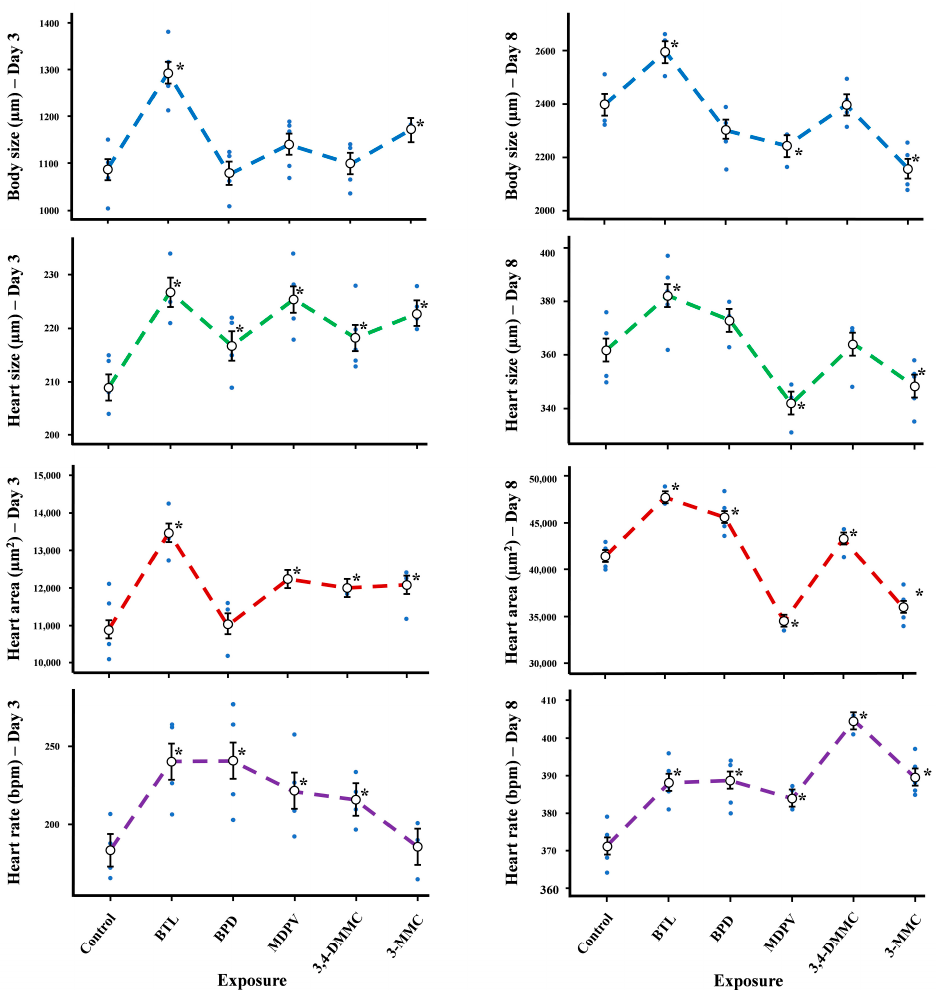
Figure 3. Morphophysiological effects (body size, heart size, heart area, and heart rate) on Daphnia magna at days 3 and 8 of exposure to BTL, 3,4-DMMC, 3-MMC, MDPV, and BPD. (Asterisks (*) represent significant differences compared to the